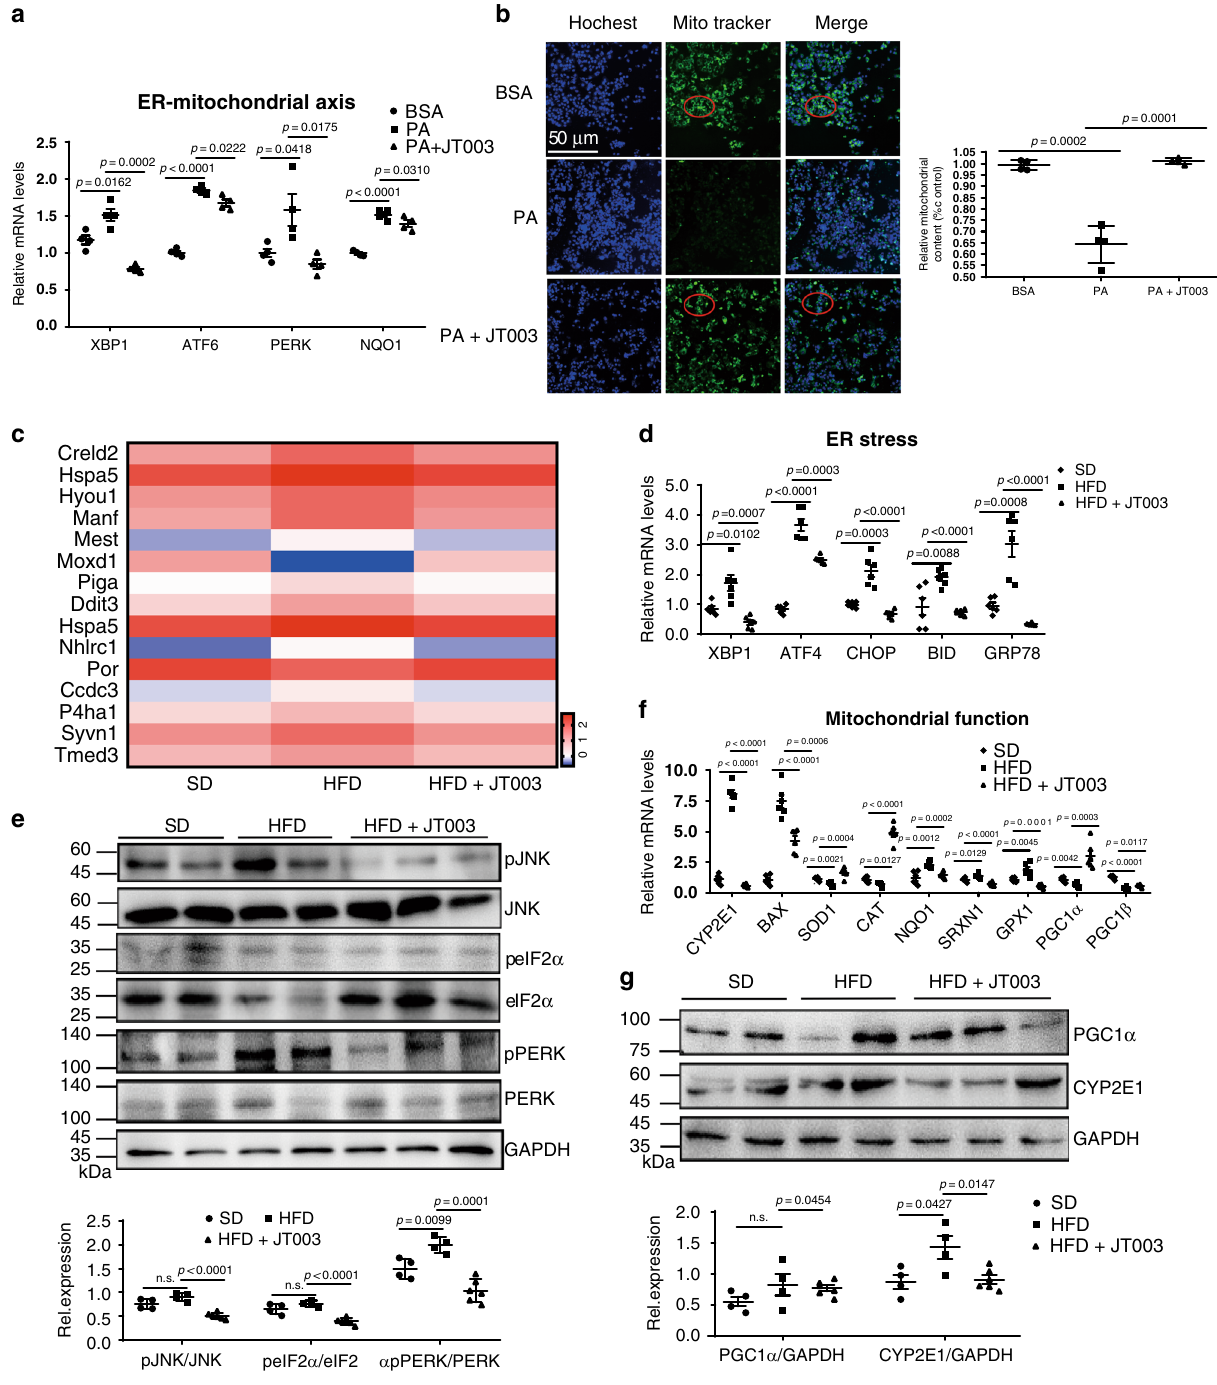
Fig. 4 JT003 recovers NASH by ameliorating ER-Mitochondrial axis function. a Quantitative RT-PCR assay was performed to determine mRNA expression of genes related to ER-mitochondrial axis in HepG2 cells of the indicated groups. b HepG2 cells of the indicated groups were stained with Mito Tracker followed by assessment with mitochondrial content assay. c Genes related to ER-mitochondrial axis which were signi fi cantly up-regulated or down- regulated in RNAseq analysis ( q < 0.001). d , f mRNA transcription of the genes related to ER stress and mitochondrial function in the liver samples of mice treated with SD, HFD or HFD plus JT003 therapy. e The phosphorylation of PERK , eIF2 α and JNK in response to ER-stress. g The expression level of PGC1 α and CYP2E1 in the indicated groups. Here and later, for each assay, three separated experiments were performed. And for each experiment ( n = 4 cell samples/group or n = 6 mice/group). For the in vivo experiment, the dose of JT003 is 500 μ g kg − 1 . All the above data are presented as mean values ± SEM using unpaired Student ’ s t test. Source data are provided as a Source Data fi